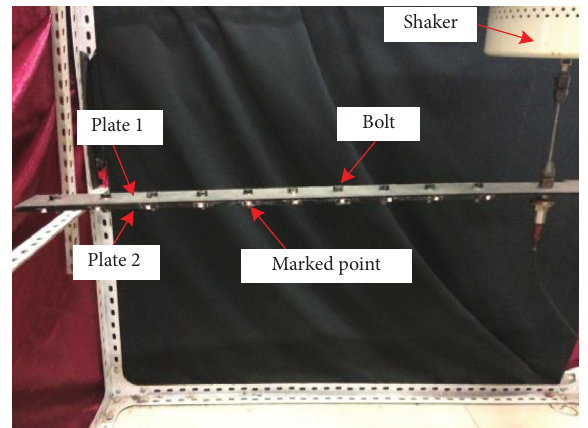
Figure 5: Shaker and bolted connection plate.